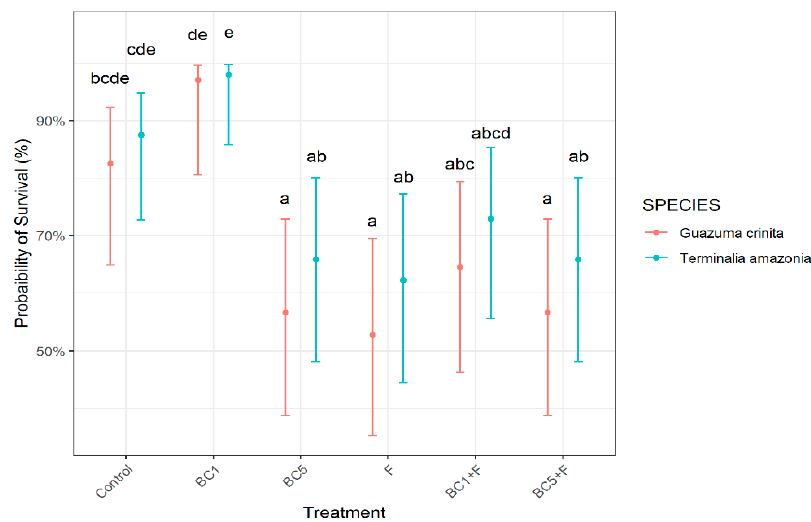
Figure 1. Probability of survival expressed as percentages among two tropical tree species in response to biochar and fertilization treatments (BC1 = Biochar 1 kg/plant; BC1 + F = Biochar 1 kg/plant + Fertilizers; BC5 = Biochar 5 kg/plant; BC5 + F = Biochar 5 kg/plant + Fertilizers; Ctrl = Control; F